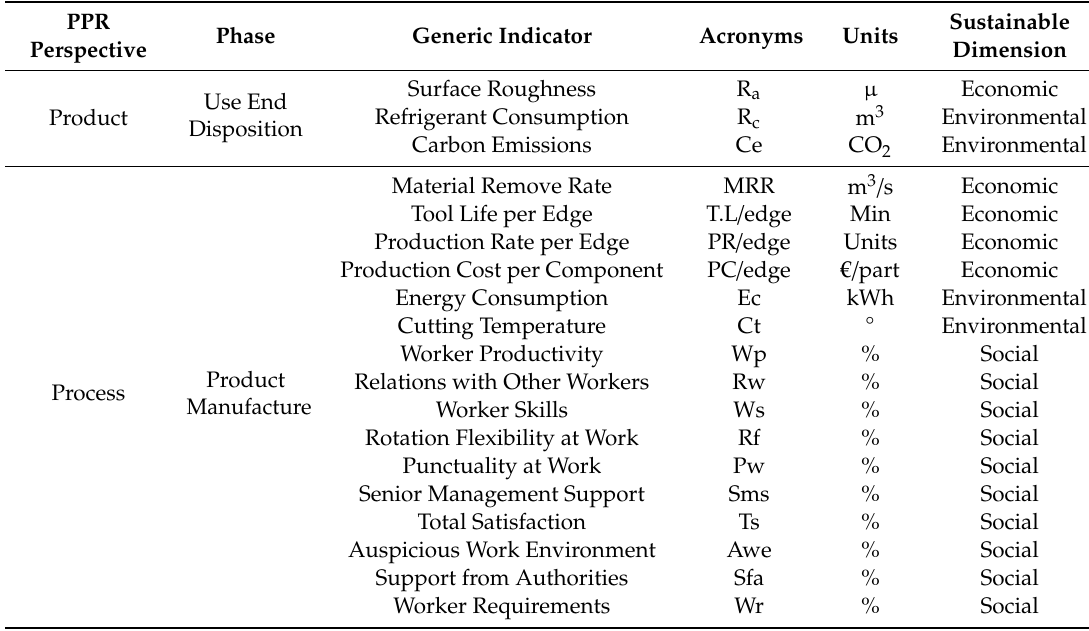
Table 2. Generic indicators for sustainable machining. PPR: Product, Process, and